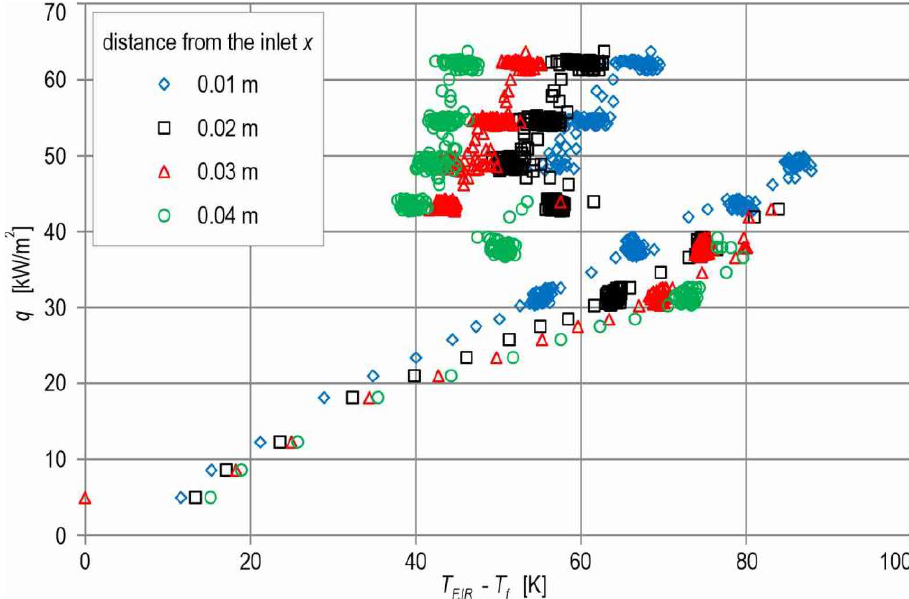
Figure 8. Boiling curves, i.e., the dependences of heat flux as a function of the temperature difference between the heated wall and the bulk fluid temperature, for four distances from the mini-channels inlet; the experimental parameters shown in Table 1.